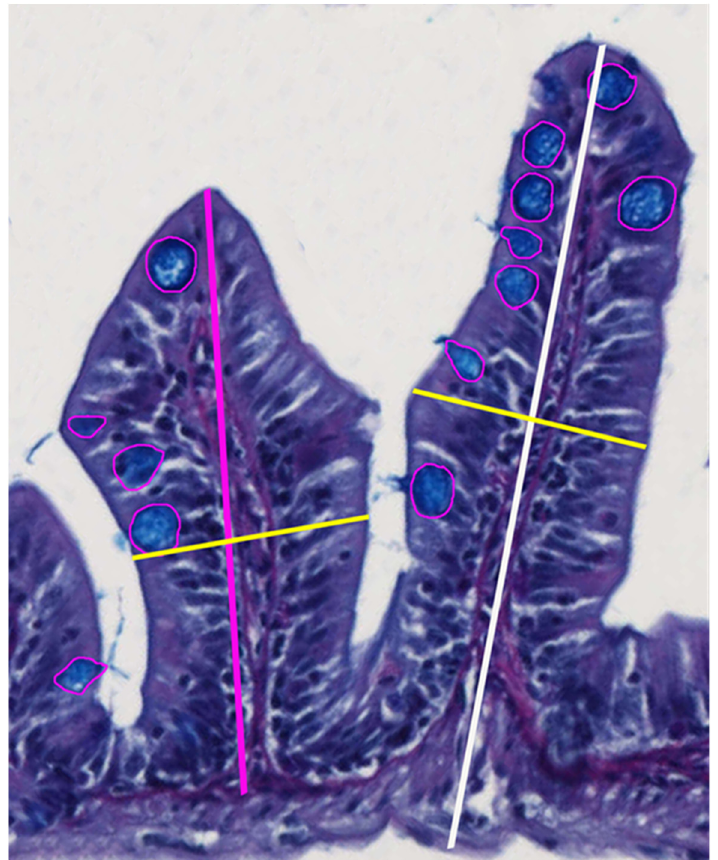
Figure 2. Photomicrograph of Alcian blue stained intestinal wall (40×). The purple and white lines indicate the height of a villus from its apex to the tunica muscularis and to the serosa, respectively. The yellow lines indicate two measurements of the intestinal villi width; goblet cells present in this frame are outlined in purple.